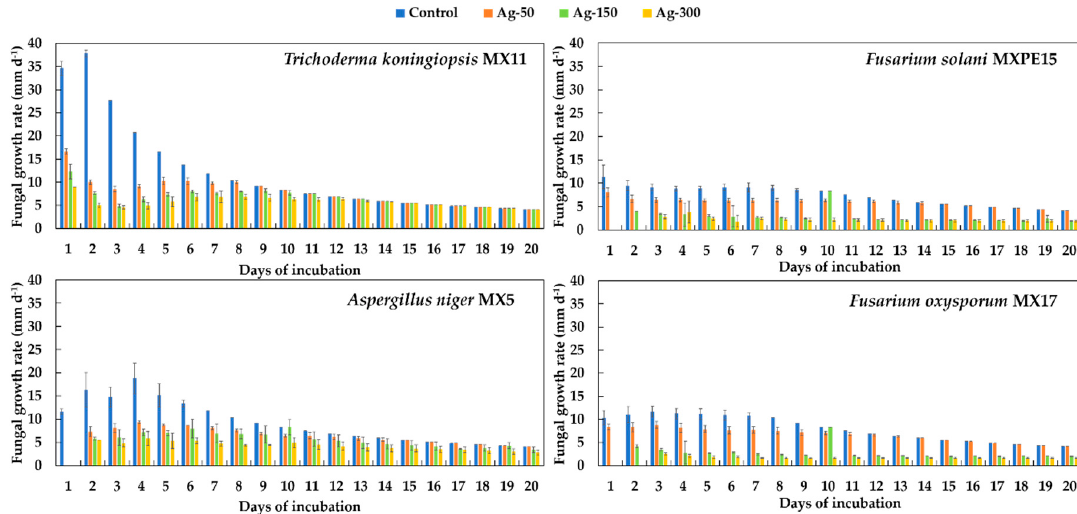
Figure 5. Fungal growth rate of four filamentous fungi strains exposed to four doses of silver (mg L − 1 ) T. koningiopsis MX11 was more tolerant than other strains (n = 3, means ± standard error).